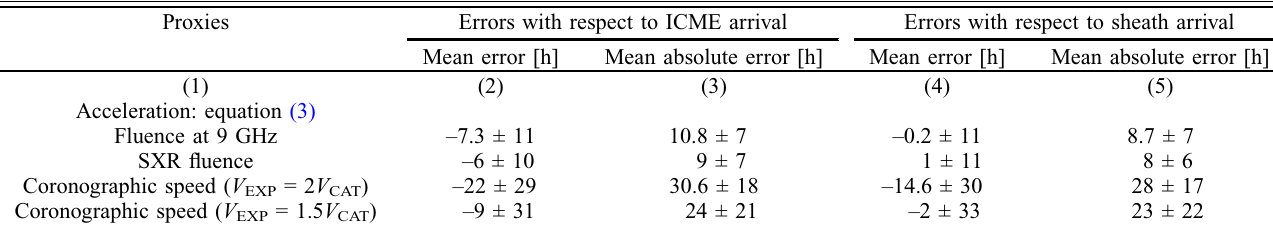
Table 4. Average differences between the predicted and observed ICME arrival times (see Table 3): col. 1 contains the proxy used to infer the CME propagation speed. Cols. 2 and 3: the mean error and the mean absolute error (negative when the predicted arrival precedes the observed ICME arrival) and their standard deviations, respectively. Cols. 4 and 5: the mean error and the mean absolute error and their standard deviations with respect to the sheath arrival.